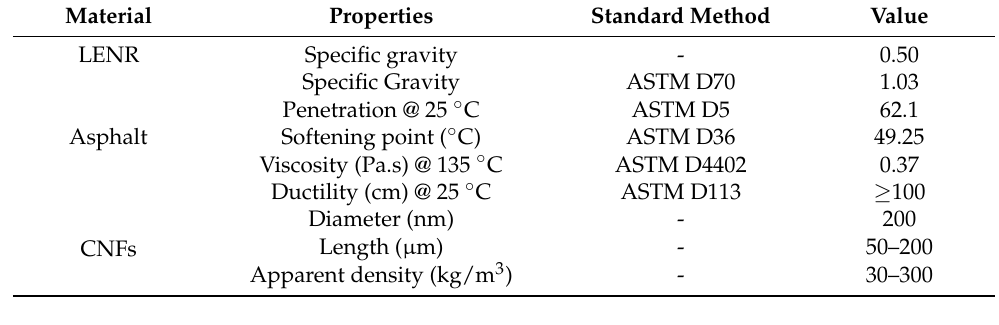
Table 1. Properties of the based asphalt, LENR polymer, and CNFs.